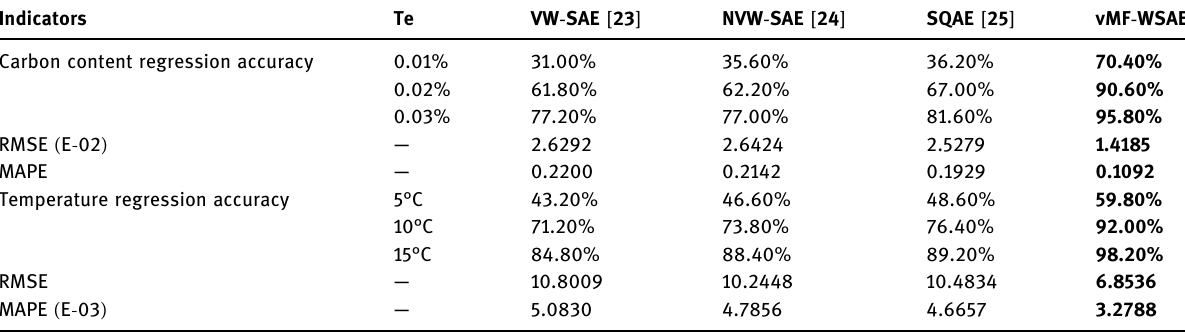
Bold represent the relative optimal value under this indicator in the comparison